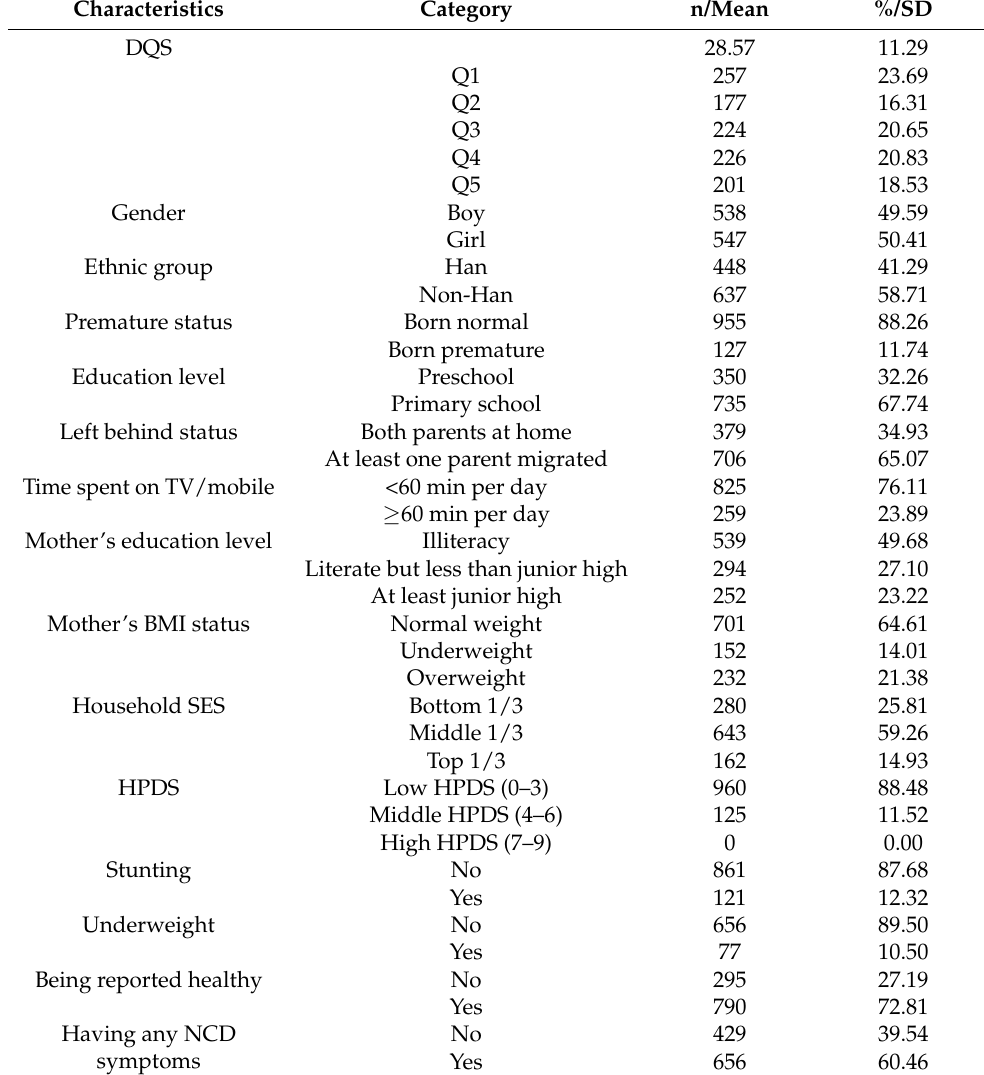
Table 1. Characteristics of sample children and their households (N =